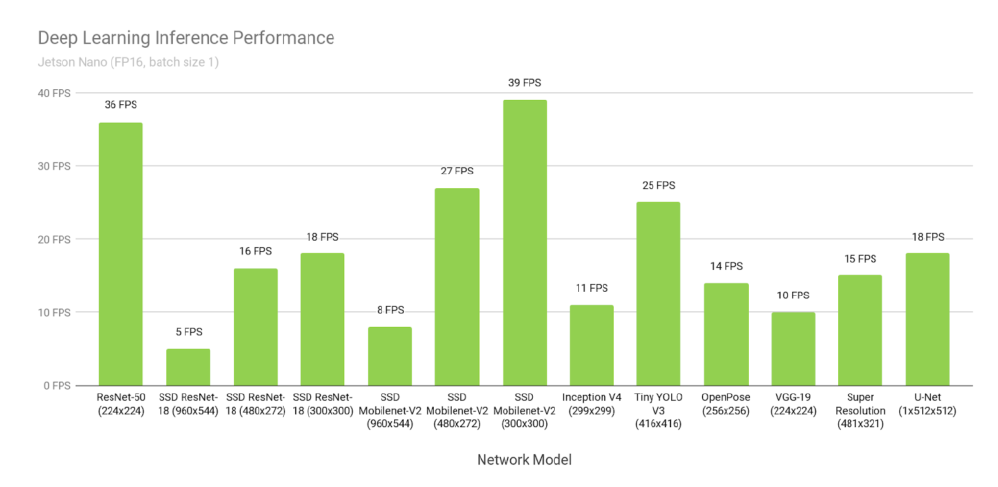
Figure 2. The comparison of various deep learning inference networks’ performance, using FP16 pre- cision and a batch size of